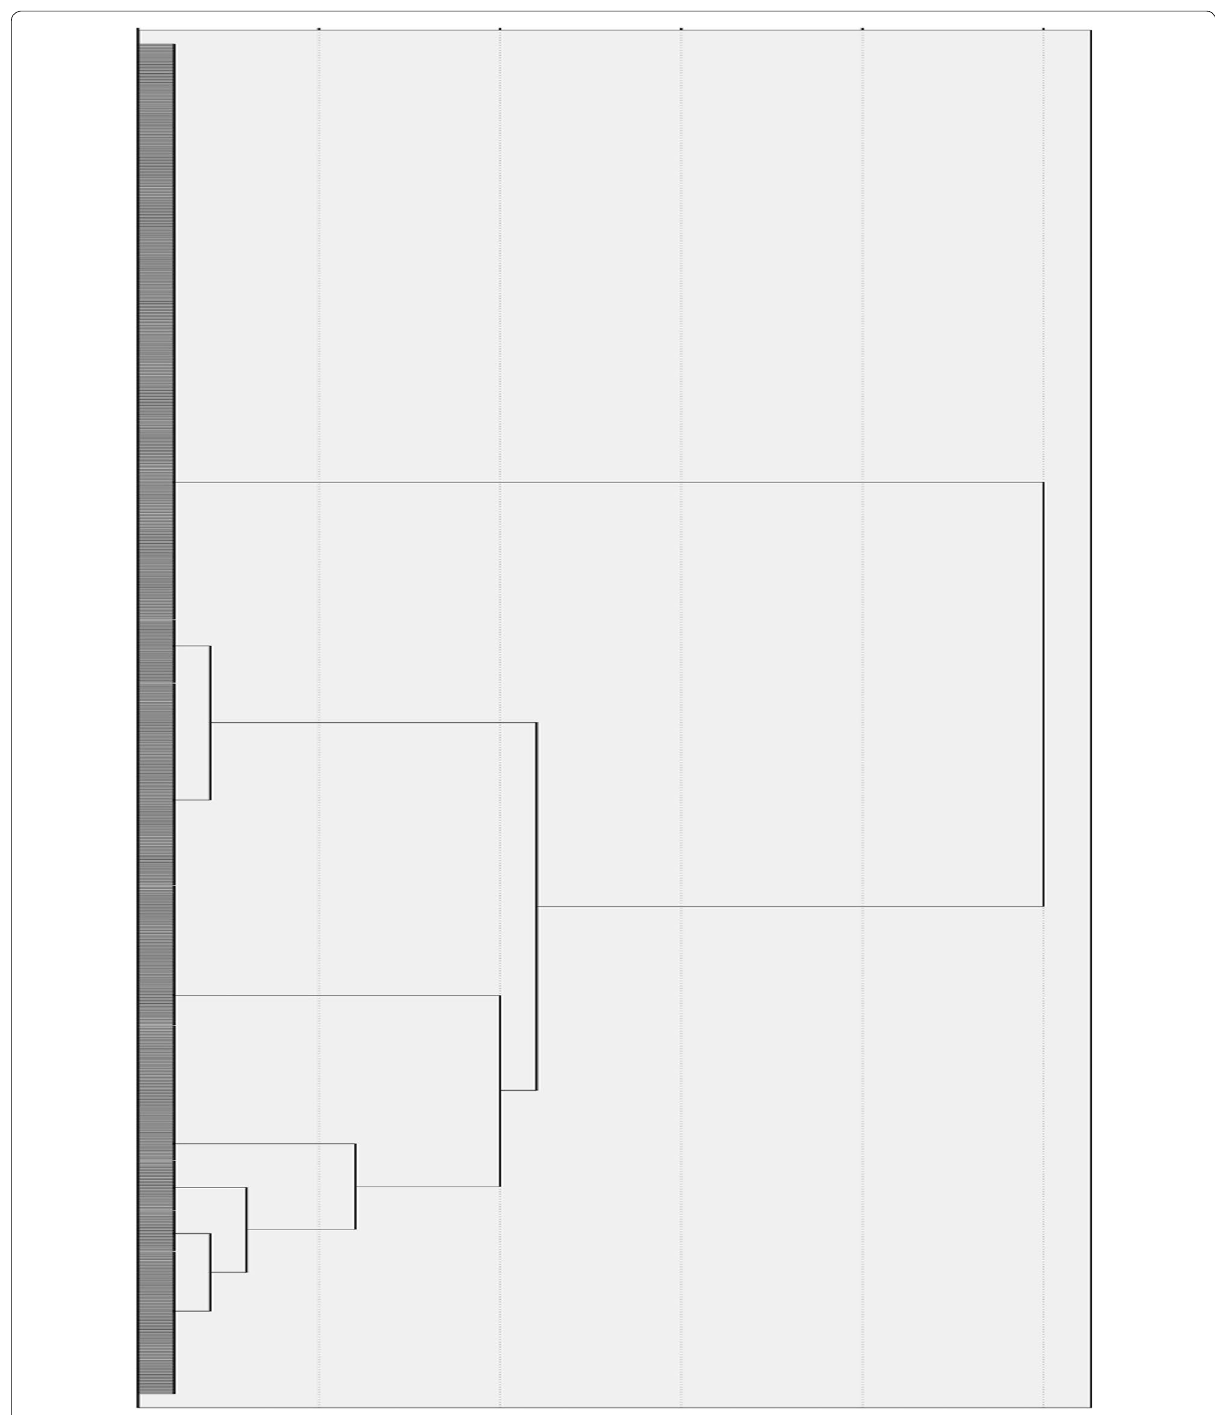
Fig. 1 Dendrogram of the clustering aggregation procedure based on Ward’s method (Source: Calculated by authors based on the 2012 Catalan Youth Survey